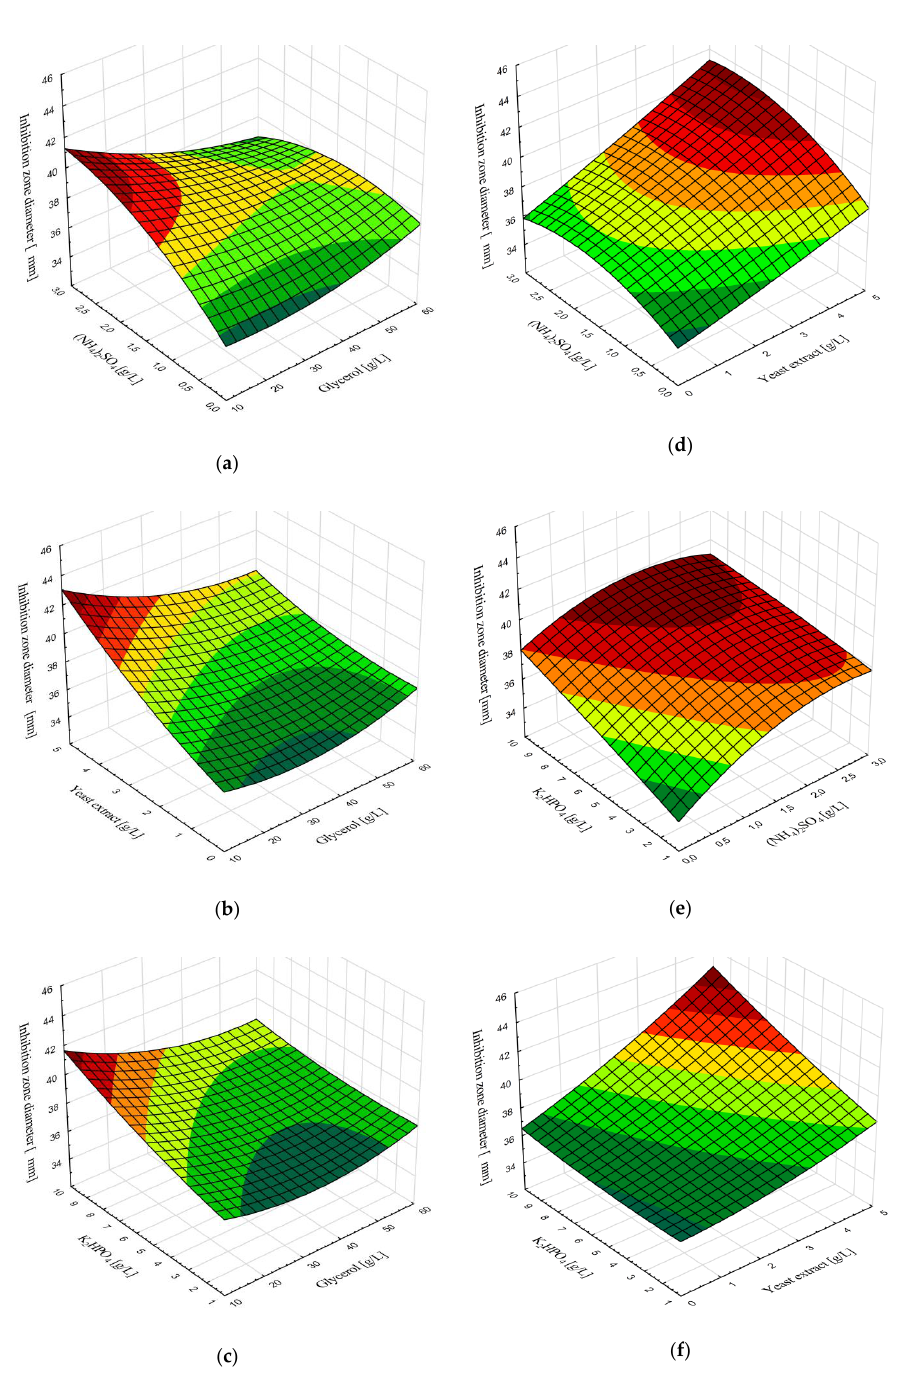
Figure 4. Response surface plots for effects of nutrients’ content on inhibition zone diameter for the following combination of independent variables: ( a ) glycerol and (NH 4 ) 2 SO 4 , ( b ) glycerol and yeast extract, ( c ) glycerol and K 2 HPO 4 , ( d ) (NH 4 ) 2 SO 4 and yeast extract, ( e ) (NH 4 ) 2 SO 4 and K 2 HPO 4 , ( f ) yeast extract and K 2 HPO 4